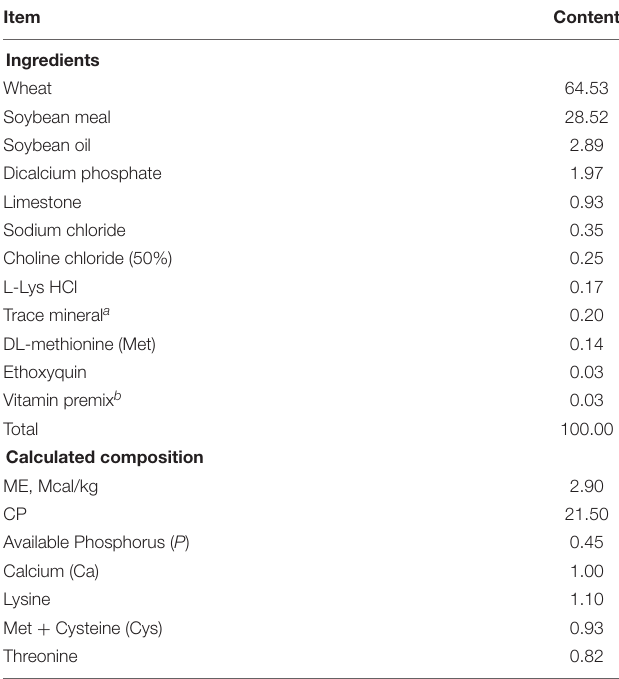
TABLE 1 | Composition and nutrient levels of diets